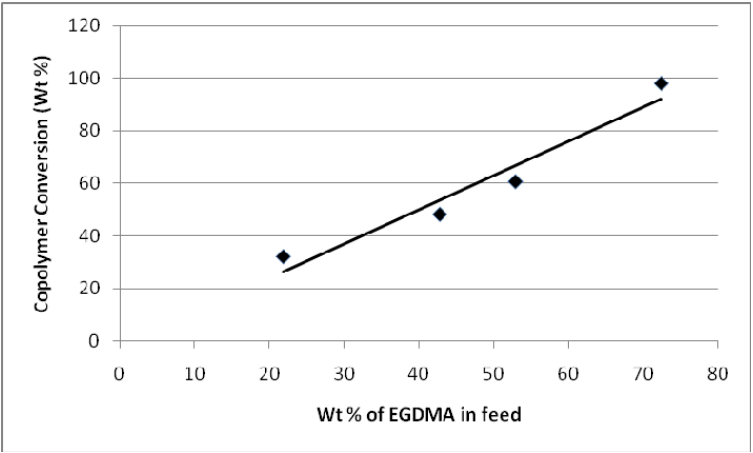
Figure 20. Copolymer conversion (wt %) vs. wt % of EGDMA in